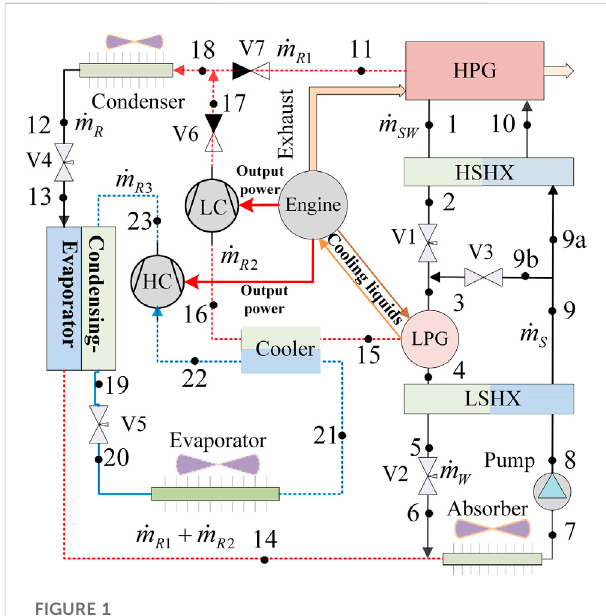
FIGURE 1 The combined absorption-compression cascade refrigeration